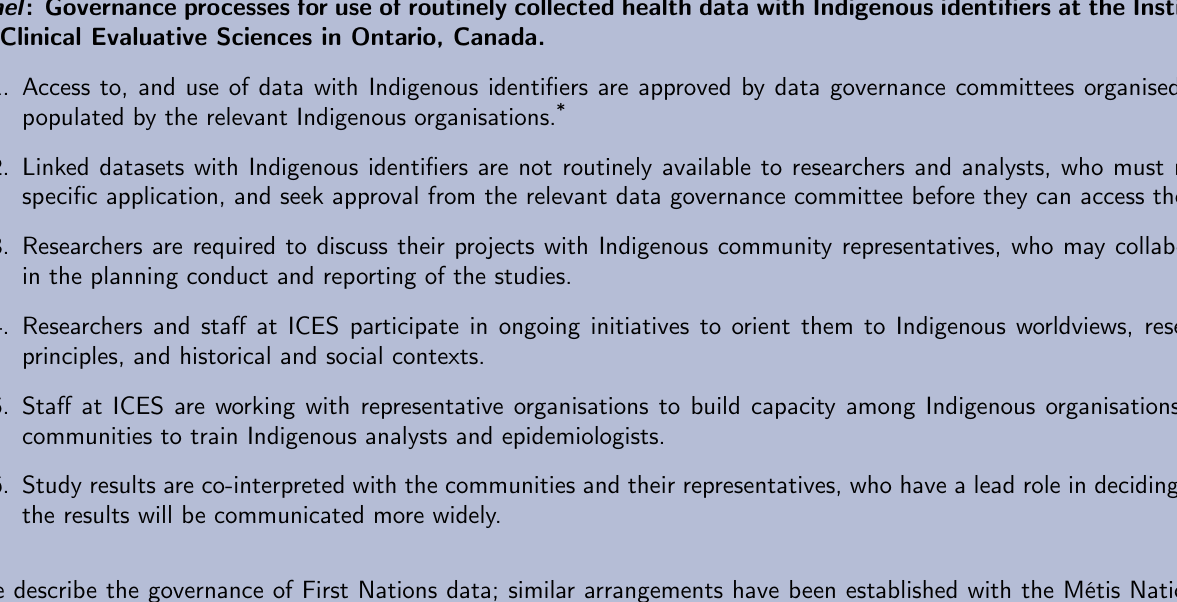
Figure 1: Governance processes, reproduced with permission from Walker et al.